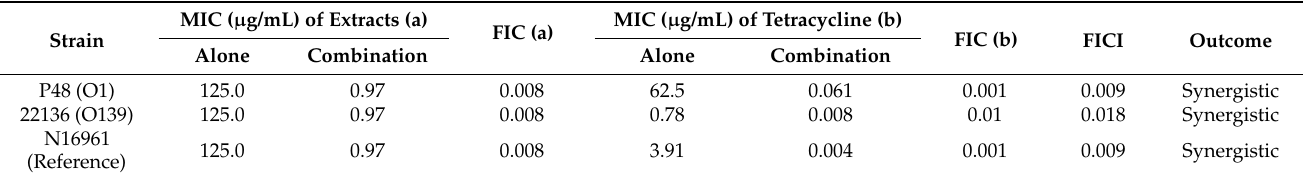
Table 2. Synergistic effect of EGCG in combination with tetracycline against reference and V. cholerae MDR